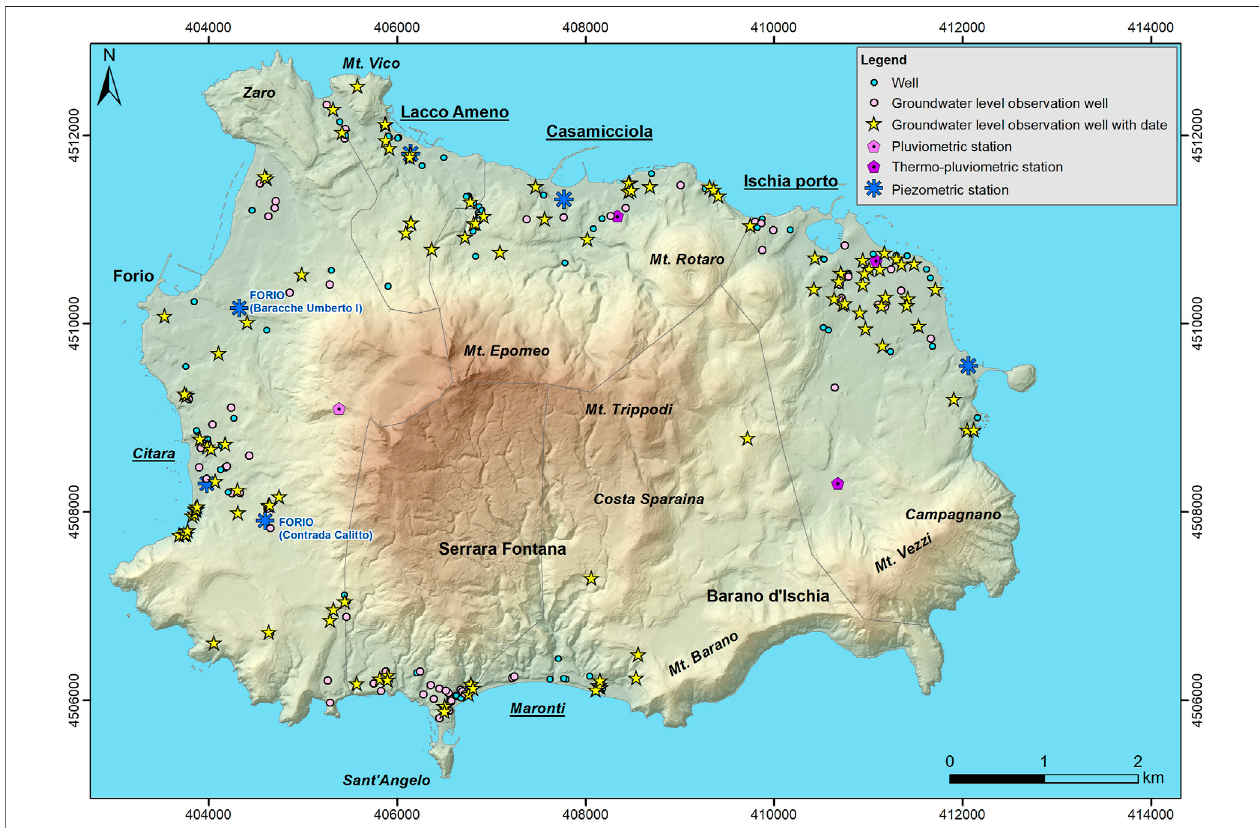
FIGURE 2 | INGV-GIS groundwater database in the Ischia volcanic island. Available site descriptive information includes well location and groundwater level data. The National Hydrographic and Mareographic monitoring network is also indicated. The digital elevation model (DEM) derivesfrom the Regional Technical Map, scale 1: